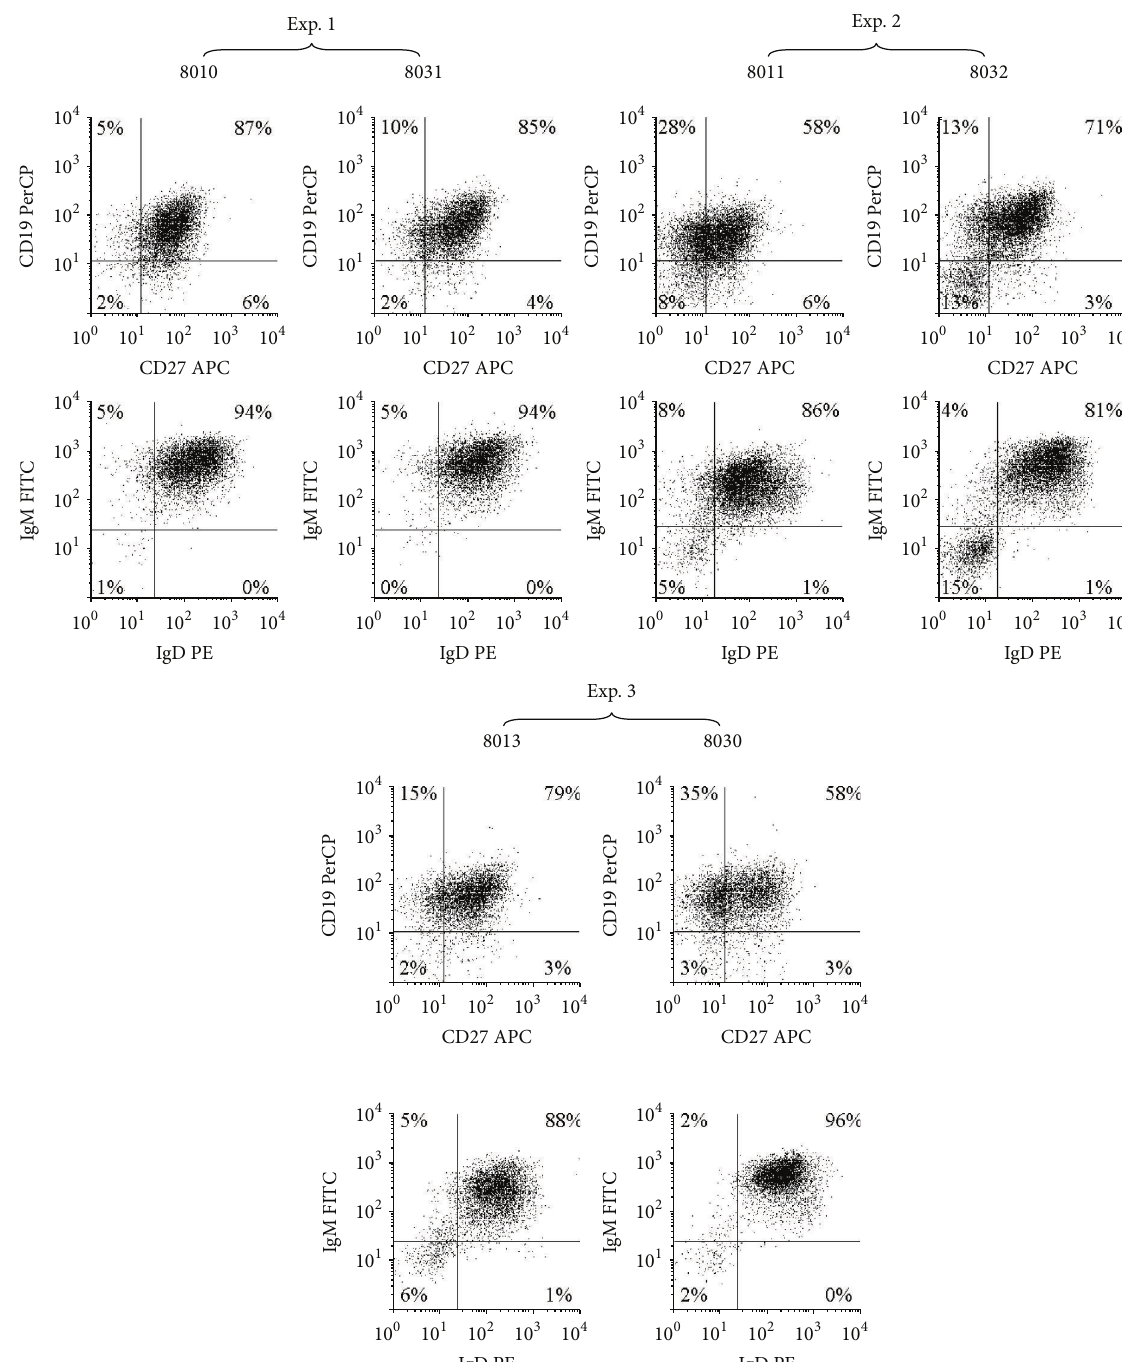
Figure 1: Phenotypes of B cells isolated from the blood samples of six patients with persistent polyclonal B cell lymphocytosis. Flow cytometry analysis of CD19, CD27, IgD, and IgM expression was done on purified peripheral B cells. More than 95% of purified cells were CD19 + CD40+ cells for all these patient samples. All analyses were done as described in